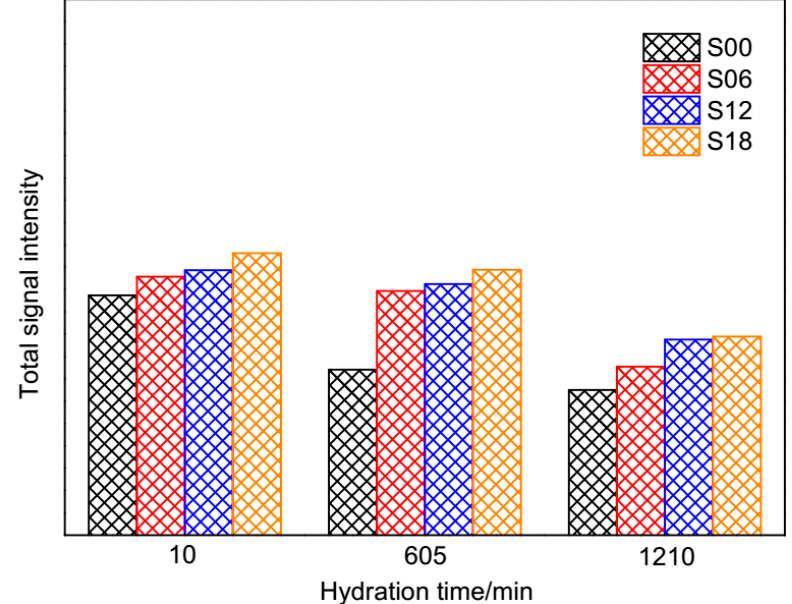
Figure 6. The total signal intensity of cement pastes at different hydration times.